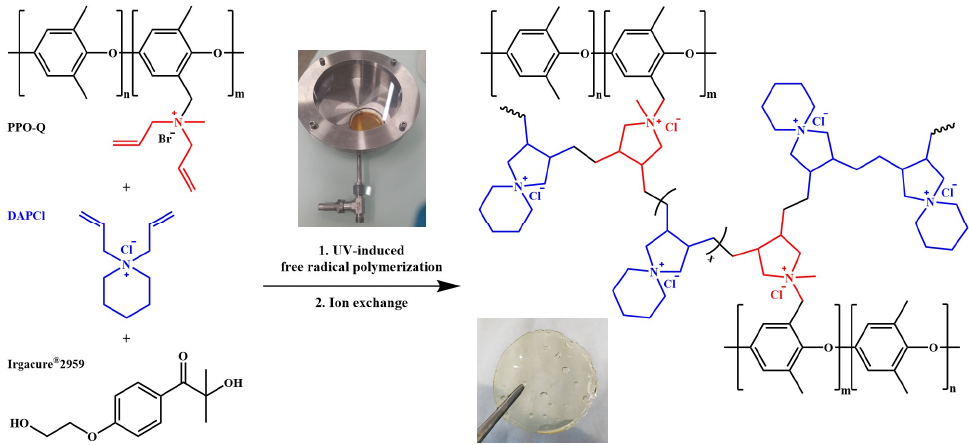
Figure 1. Schematic representation of the membrane preparation procedure.